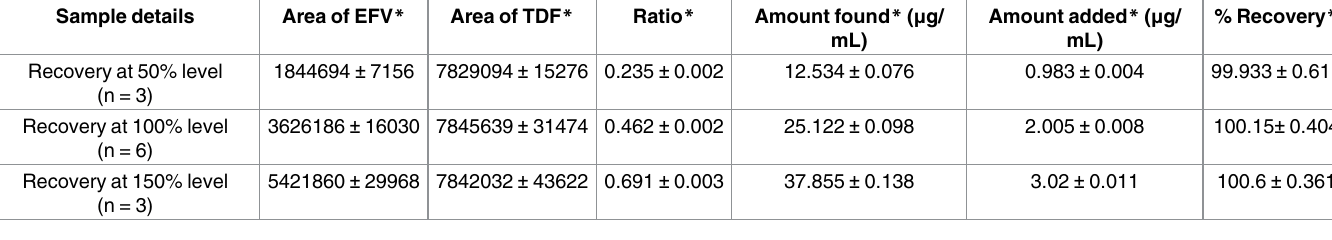
Table 3. Data of recovery study for